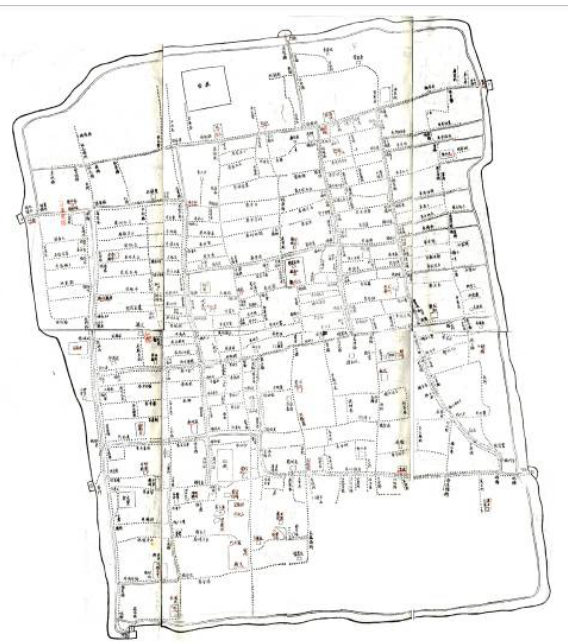
Figure 17. The map of Suzhou from 光緒蘇州府志 Guangxu Gazetteer of Suzhou Prefecture .